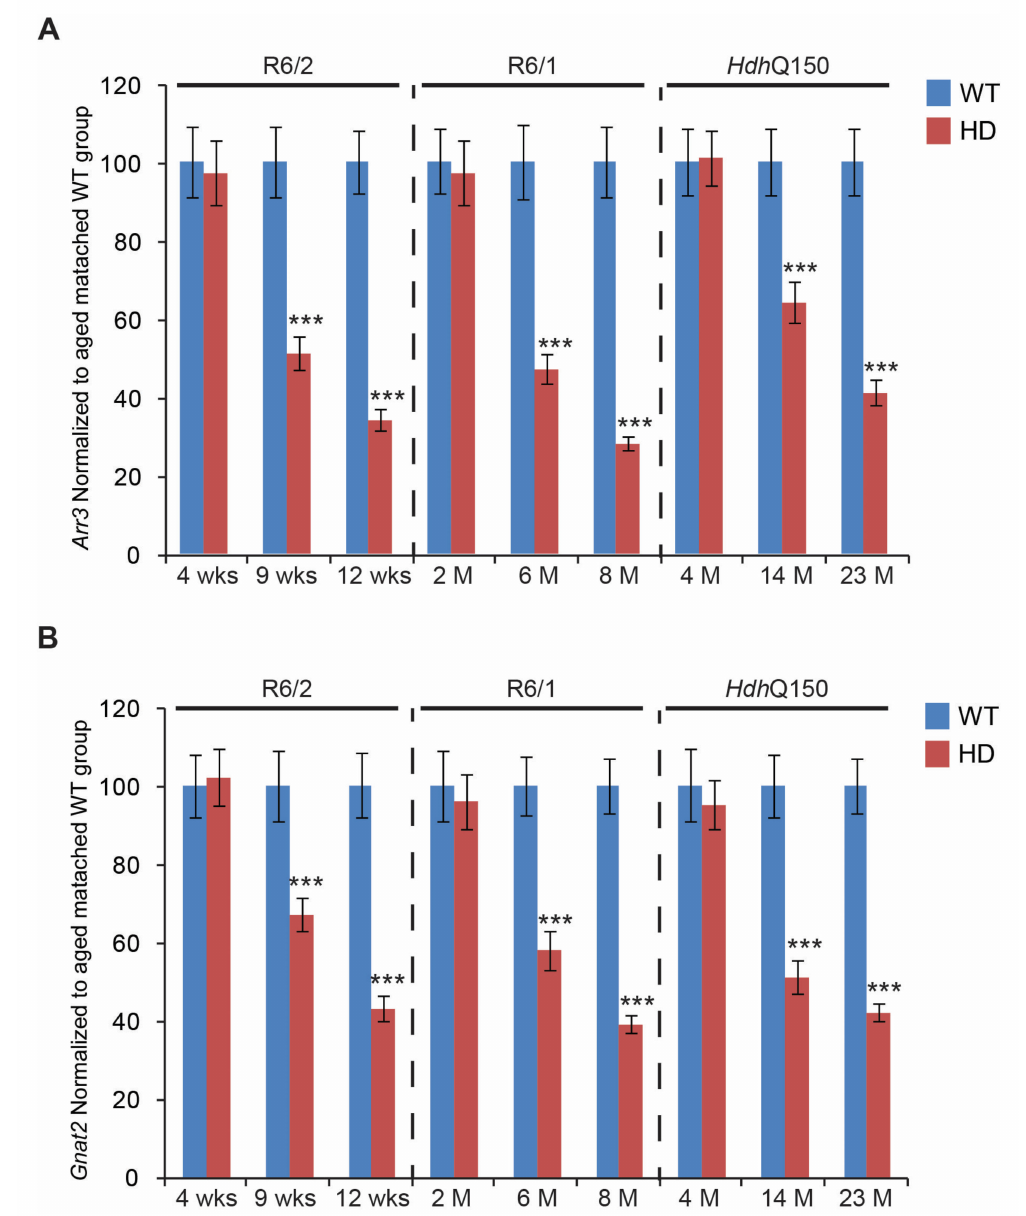
Figure 4. Transcriptional reductions of cone-specific genes. Transcripts of ( A ) Arr3 (Arrestin 3, retinal) , ( B ) Gnat2 (G protein subunit alpha transducin 2), were assessed in the eyes of three HD mouse models at: pre-symptomatic stage (4 weeks R6/2 mice, 2 months R6/1 mice, and 4 months Hdh Q150 mice); symptomatic stage (9 weeks R6/2 mice, 6 months R6/1 mice, and 14 months Hdh Q150 mice), and end-stage (12 weeks R6/2 mice, 8 months R6/1 mice, and 23 months Hdh Q150 mice). All Taqman qPCR values were normalized to the geometric mean of three housekeeping genes, as indicated in the Material and Methods section. Error bars are ± SEM (n = 6). SEM represents biological replicates. Student’s t -test: *** p <